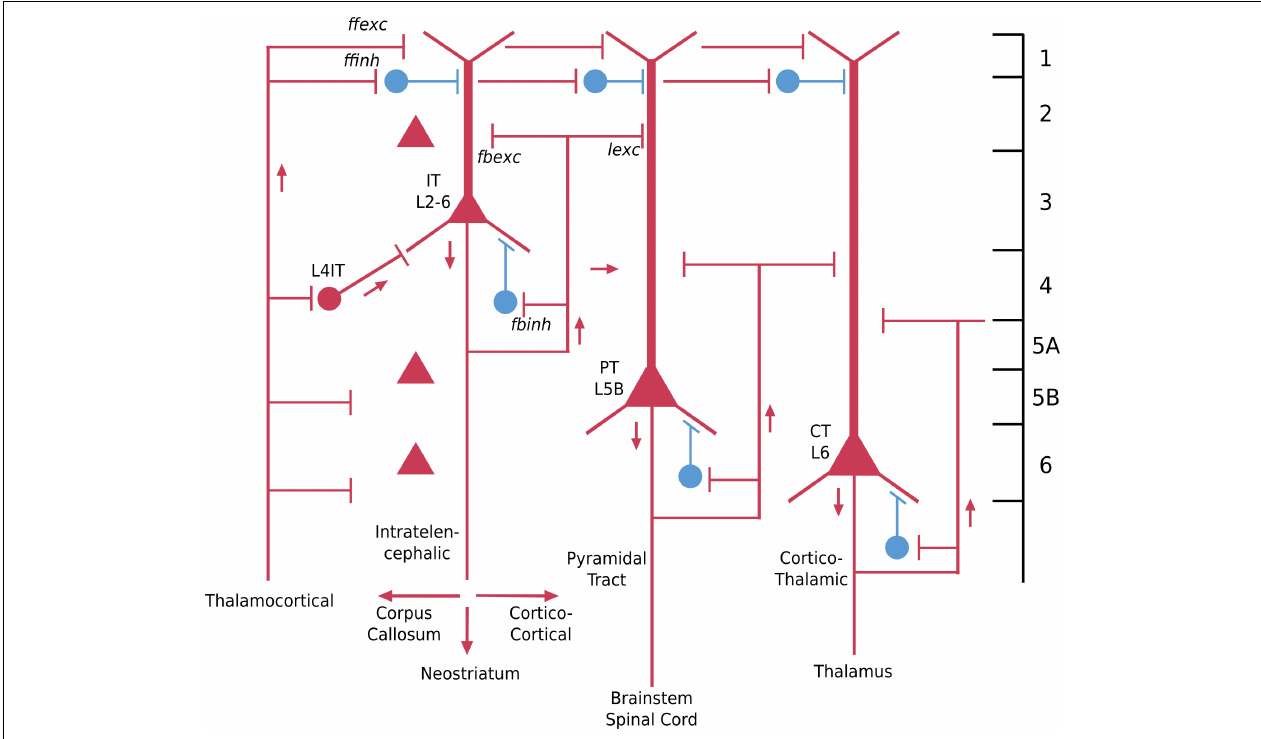
FIGURE 6 | Basic pyramidal cell (principal neuron) types (in red) in the adult neocortex in relation to the six layers and to the three connectivity types: intratelencephalic (IT), pyramidal tract (PT) and corticothalamic (CT). Interneuron examples (in blue) are superficial cells in layer 1, and basket-cell types in relation to pyramidal cell bodies. Red color indicates excitatory neurons, blue indicates inhibitory neurons [Adapted from Shepherd and Rowe (2017)]. Region Conn Trad.